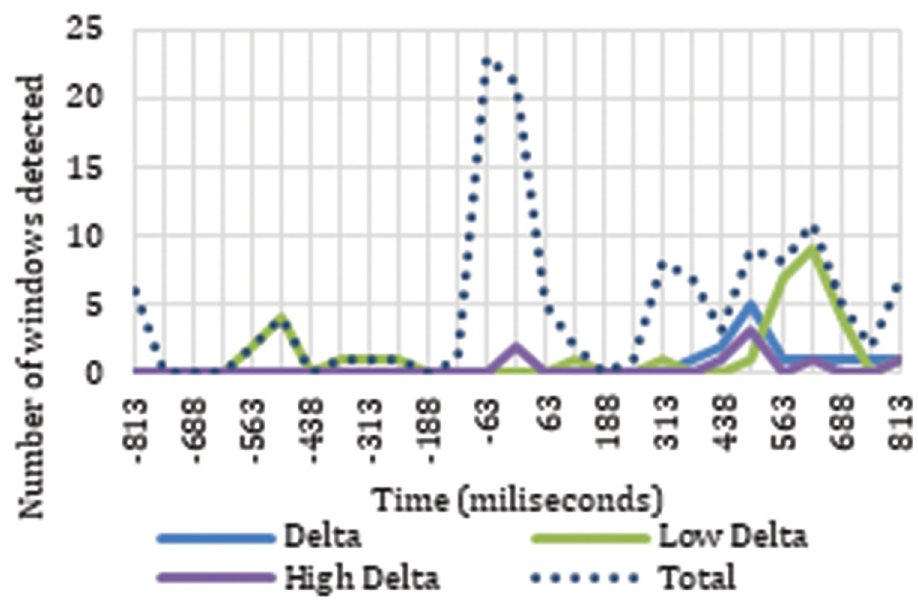
Fig 6. Distribution of sliding windows detected as triggered by the cut in delta